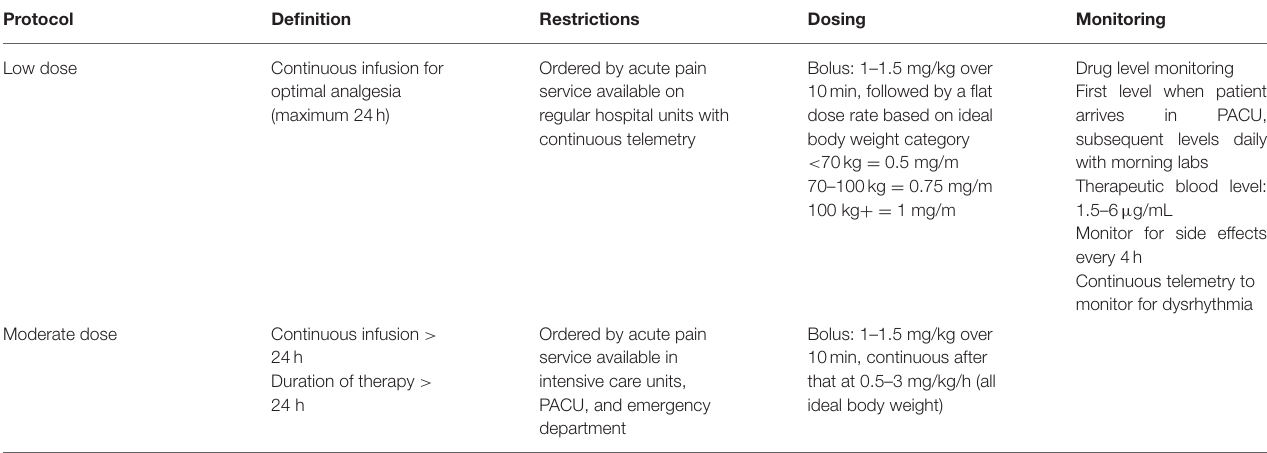
TABLE 3 | University of Chicago inpatient lidocaine infusion protocol.